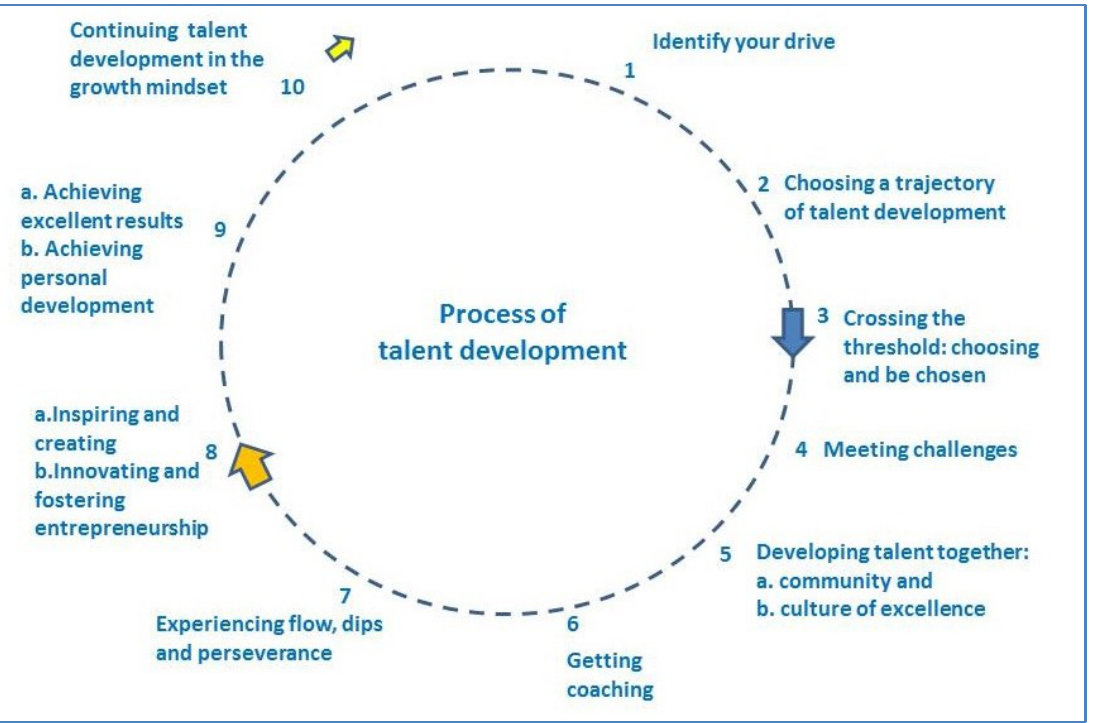
Figure 1: The ten steps into the Circle of Talent Development